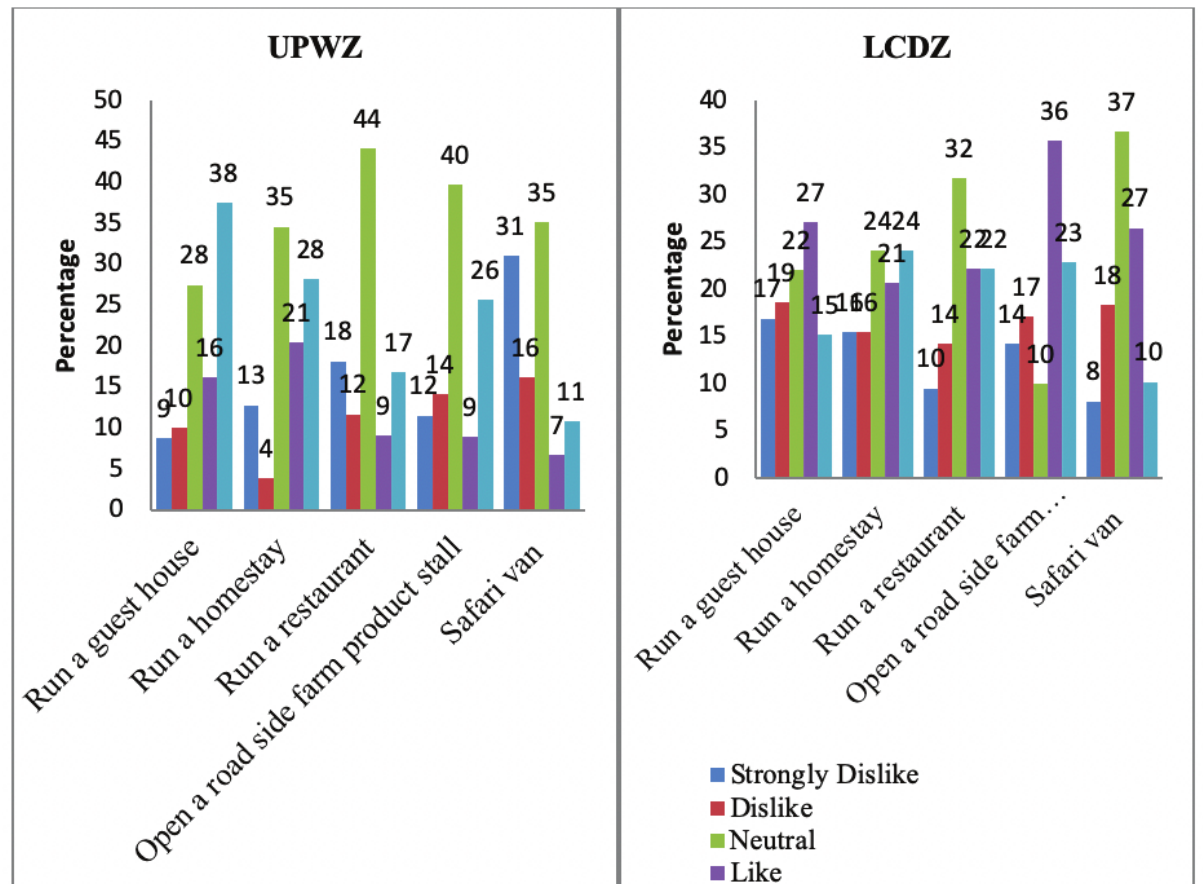
Figure 6: How do you like to involve in